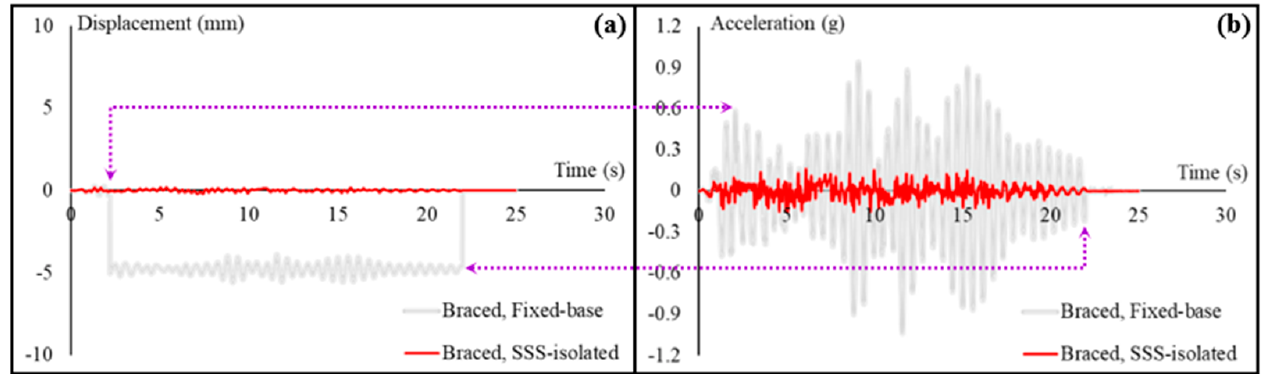
Figure 10. Seismic responses of the cart in the braced condition on the shaking table: ( a ) comparison of the displacement responses in the fixed-base and SSS-isolated hospital building; ( b ) comparison of the acceleration responses in the fixed-base and SSS-isolated building.